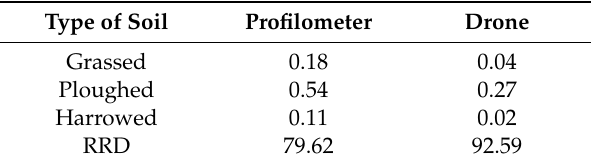
Table 3. Standard deviation values (in mm) for profilometer and light drone plots for the 3 types of soil (ploughed, harrowed and grassed) and roughness reduction degree (RRD; ploughed / harrowed). Type of Soil